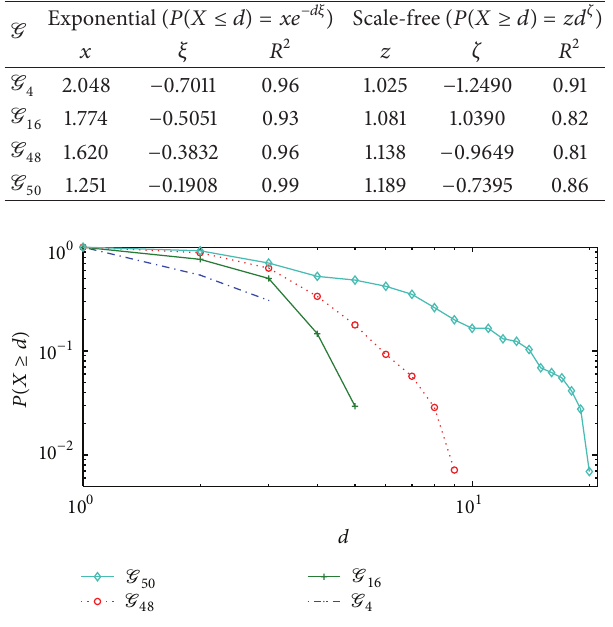
Figure 4: CDF of test power